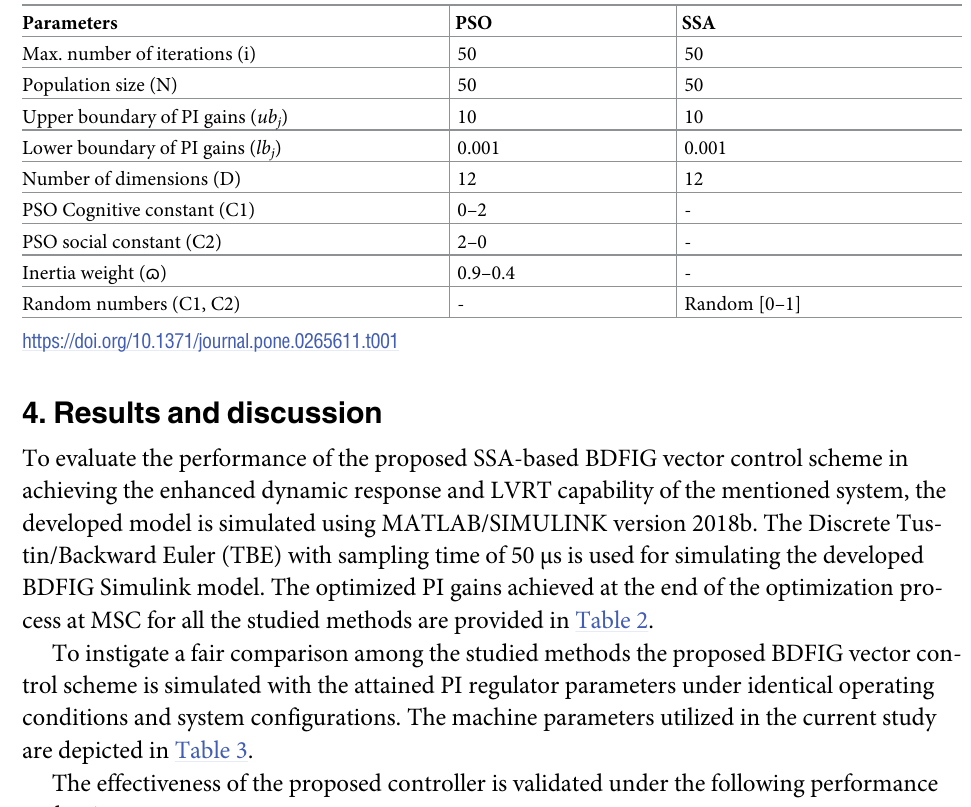
Table 1. Optimization parameters.